Question: Describe this figure in one sentence.
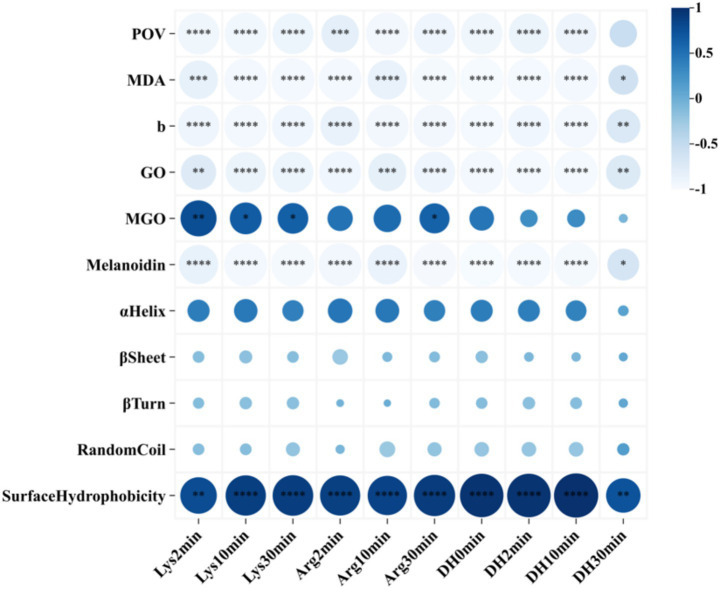
Answer: Pearson correlation analysis of lipid oxidation, non-enzymatic glycation, milk protein structure index and degree of protein hydrolysis of milk.